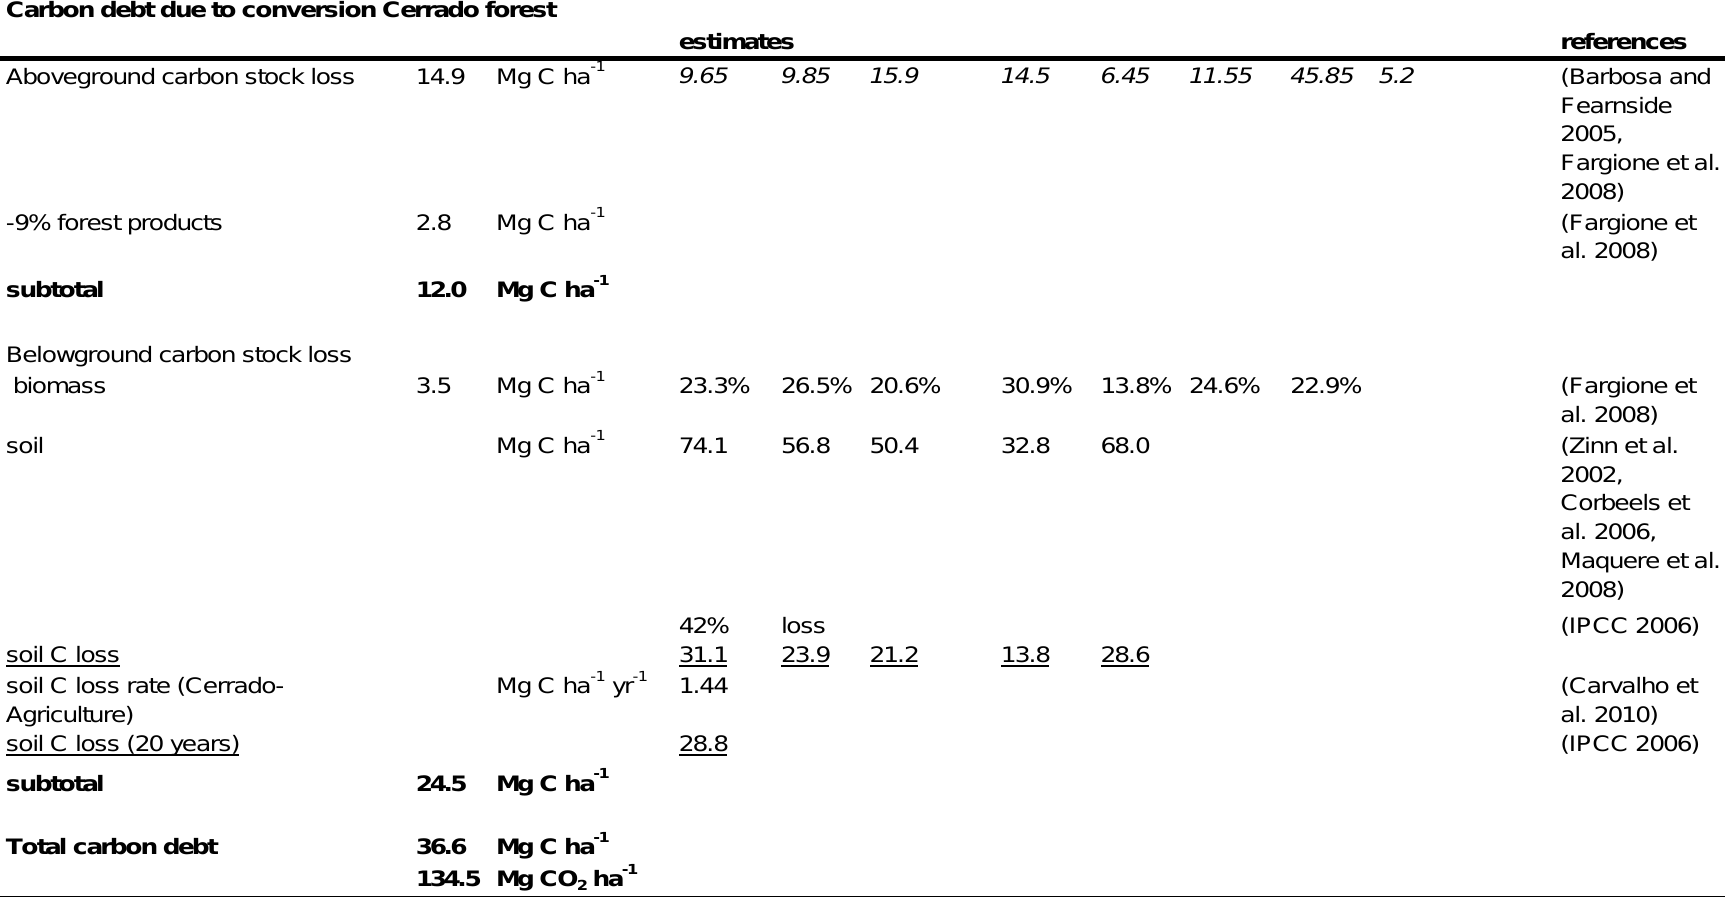
Table A6.1. Carbon debt calculation of Sorriso, Brazil